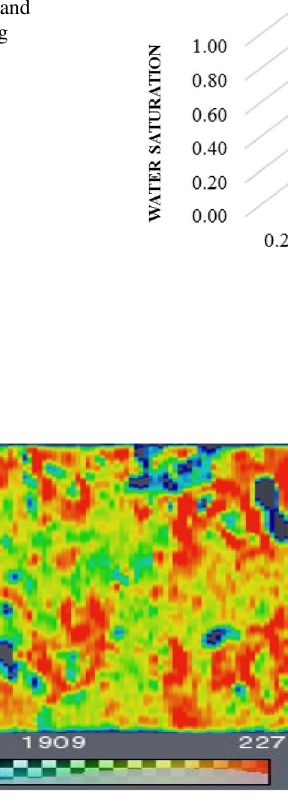
Fig. 6 Comparison between volumetric production data and in situ saturation data during Exp. 1